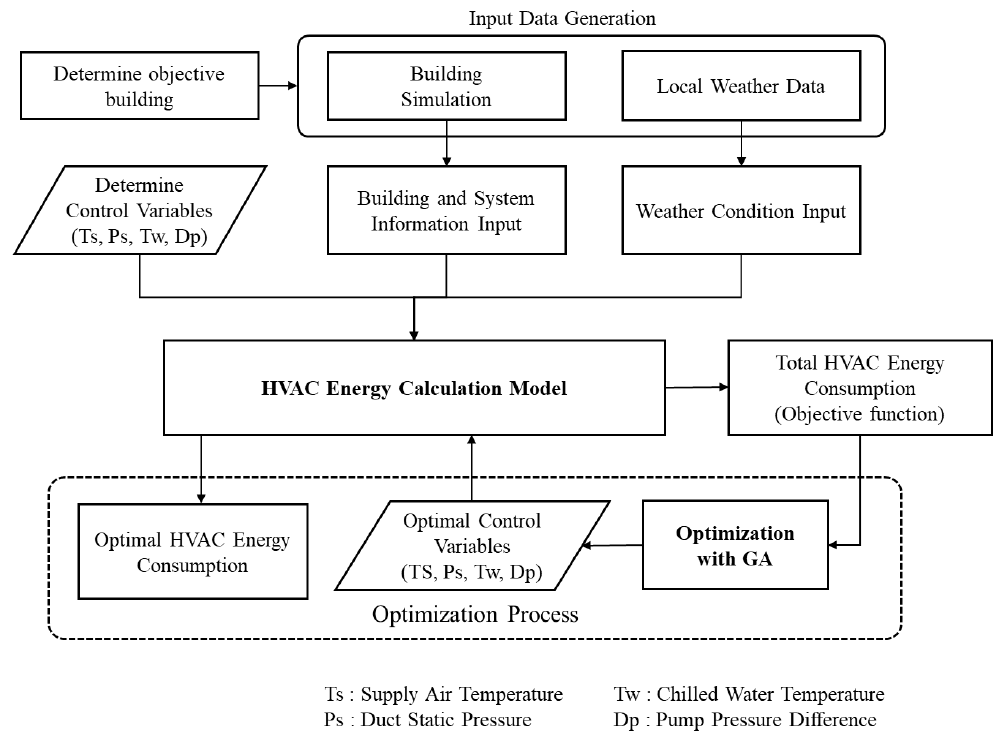
Figure 3. Flowchart of the energy calculation model and optimization process for the HVAC system.